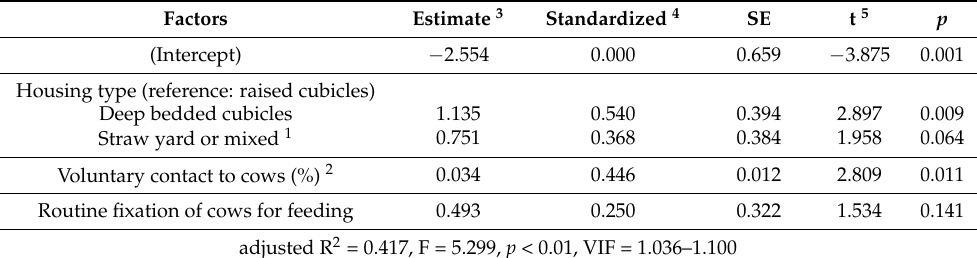
Figure 2. Observed QBAscores ( y -axis) at different intensities of voluntary contact to cows ( x -axis) in different housing systems (differentiation in color), with or without fixation for feeding (differentiation in shape), each circle or triangle represents a herd ( n = 25). Table 2. Final multivariable linear regression model regarding the outcome variable QBAscore ( n =